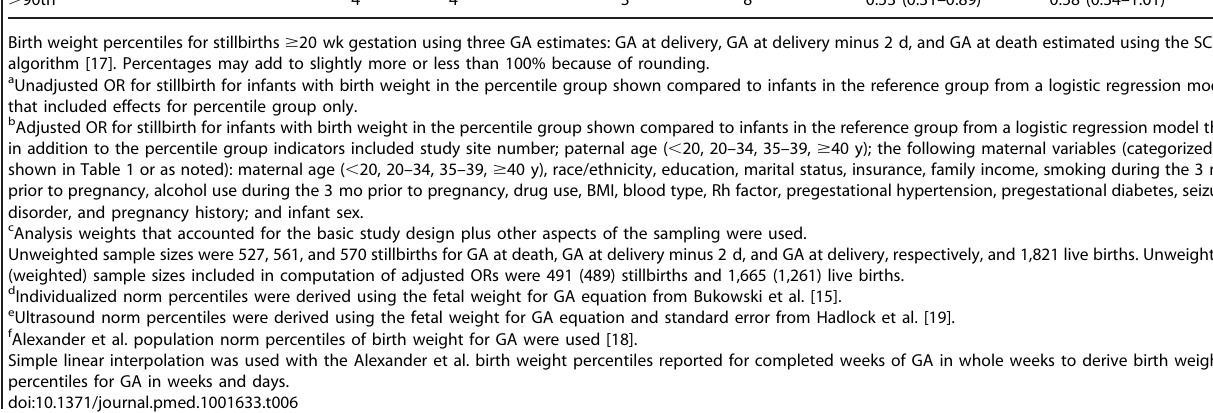
Birth Weight Norms and